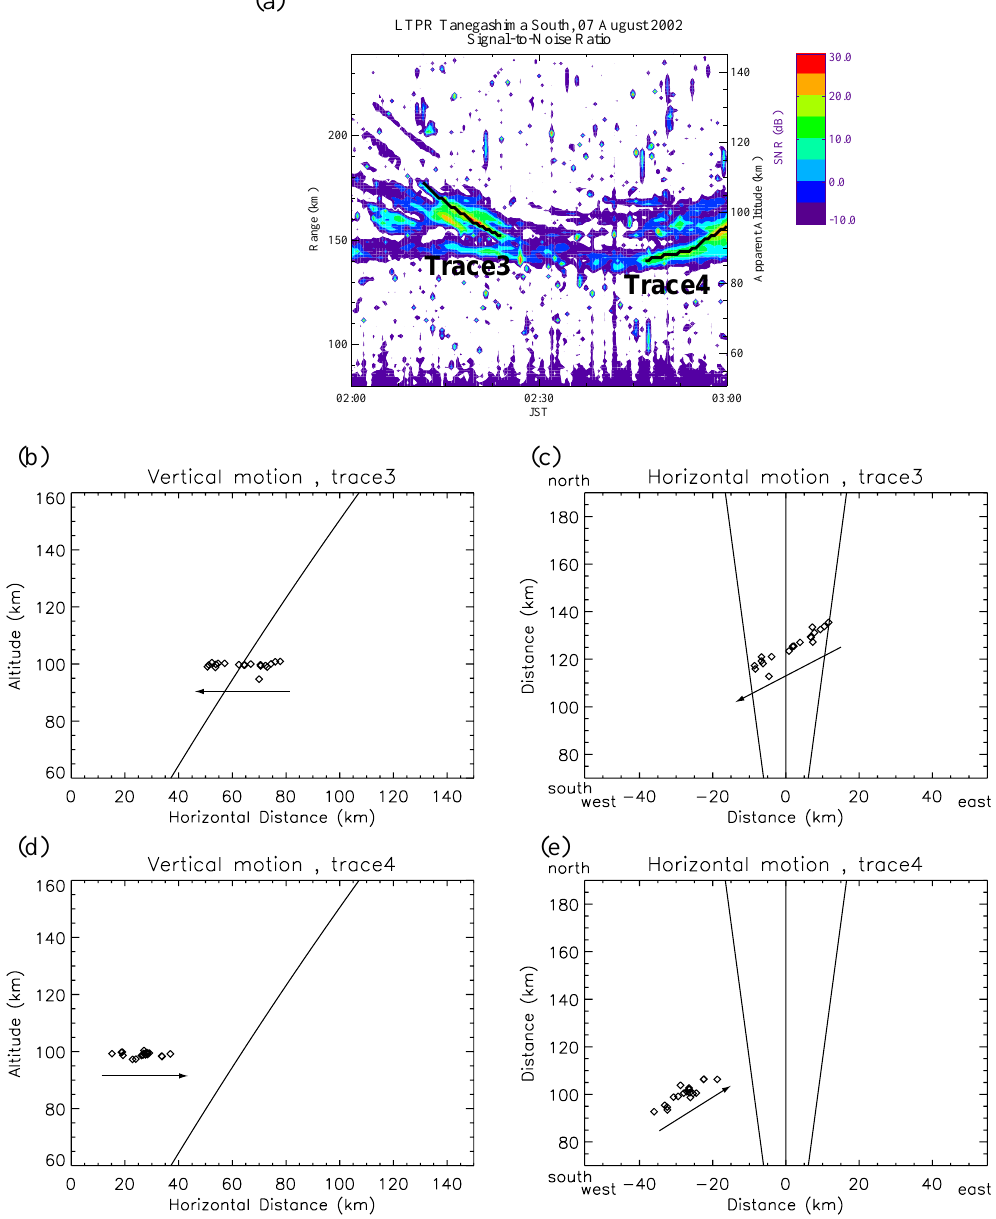
Fig. 9. Same as Fig. 8, except that 02 to 03 JST on 7 August 2002 are shown. (b) and (c) correspond to Trace 3, while (d) and (e) correspond to Trace